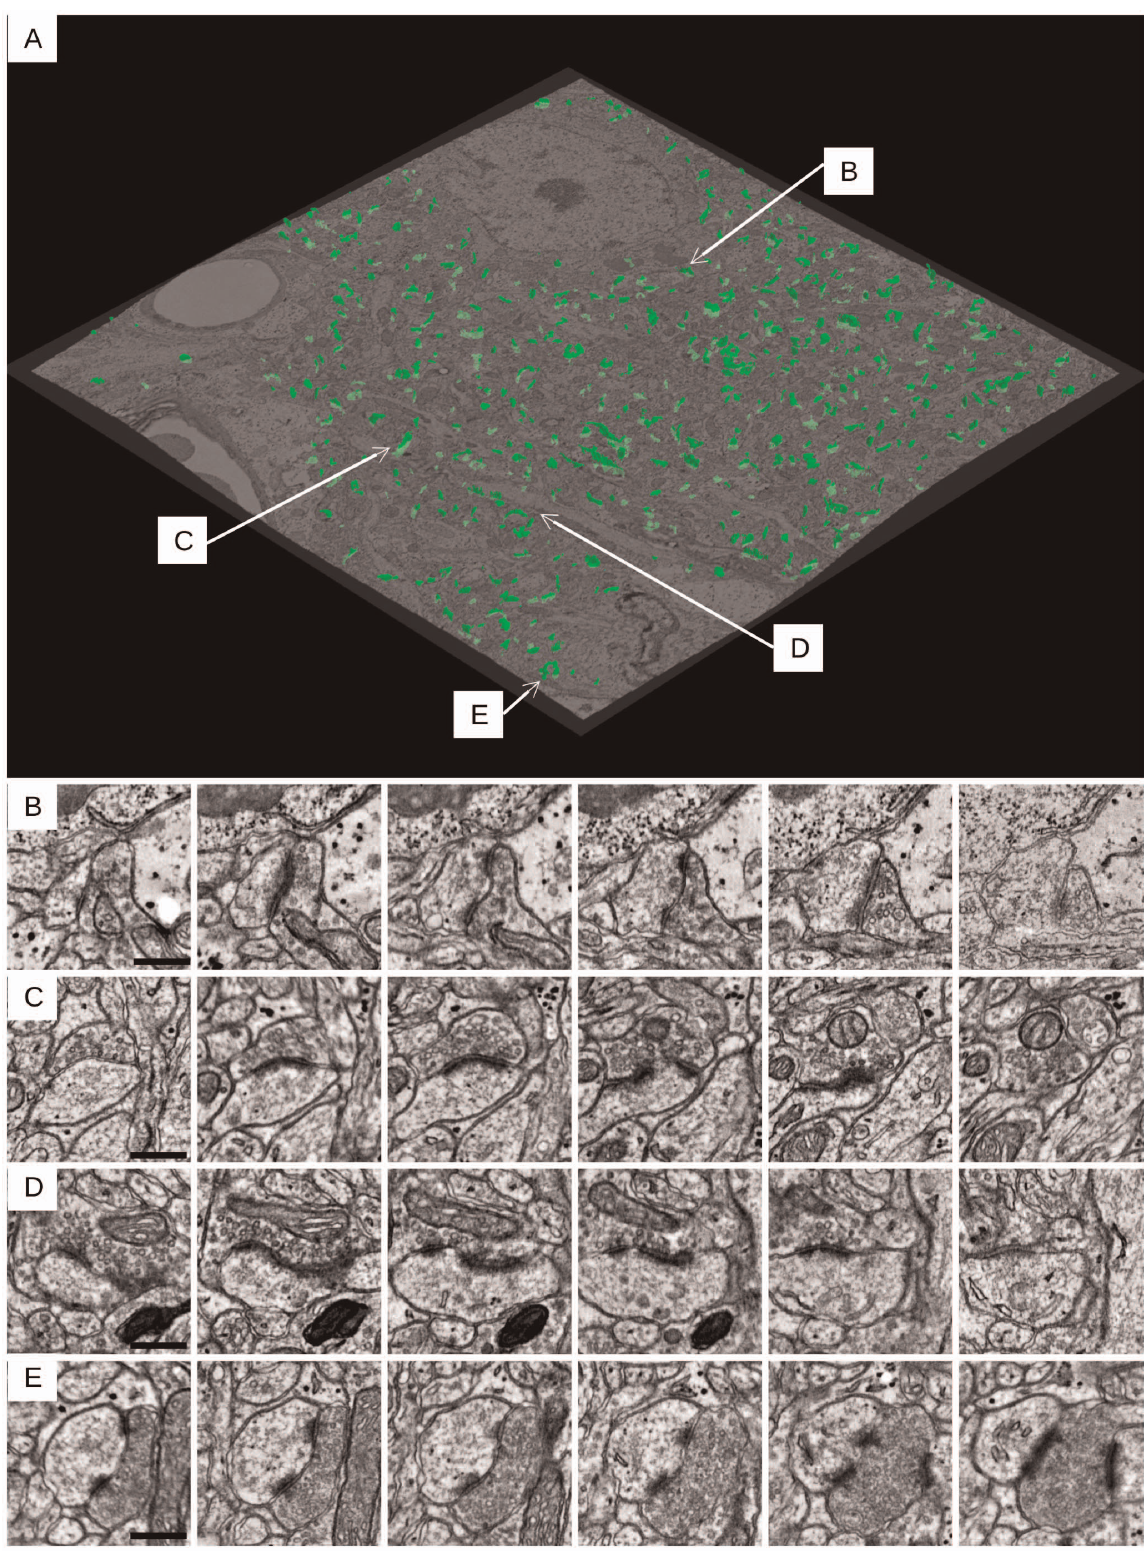
Figure 1. Synapses, detected in the test dataset. A: A 3D view of the synapses, detected in the test dataset. The detected synapses are shown in green. The central slice of the raw data is also shown for illustration (the shape distortion is caused by elastic stack registration). The data volume was downsampled by a factor of 10 in the x and y dimensions to show the full volume. B, C, D, E: More detailed synapse examples as an image series. Scale bars: 450 nm, every second slice is shown (distance between consecutive images is 90 nm).